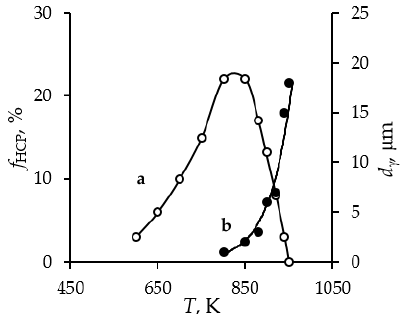
Figure 5. Dependences of the volume faction of HCP-phase ( f HCP , curve- a ) and grain size of γ-matrix ( d γ , curve- b ) of the Co-Ni-Nb alloy (preliminary quenching from 1223 K (10 min) and 90% rolling) on the annealing temperature (T).